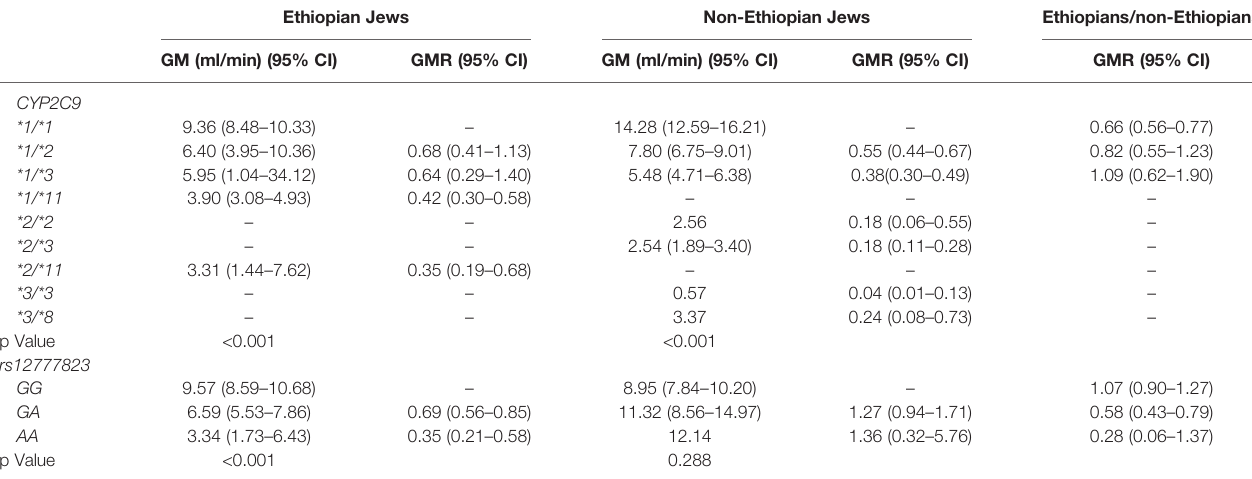
TABLE 5 | Phenytoin Metabolic Ratio 24/24 according to CYP2C9 and rs12777823 genotype in the Ethiopian and non-Ethiopian groups. Ethiopian Jews Non-Ethiopian Jews Ethiopians/non-Ethiopians